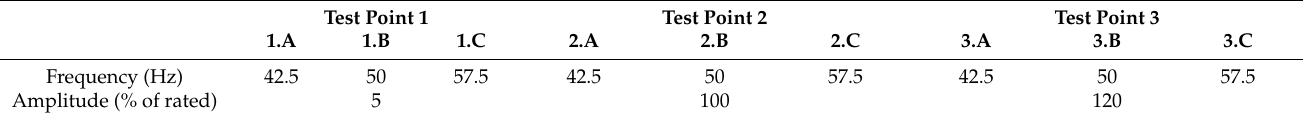
Table 5. Proposed test point for amplitude and frequency